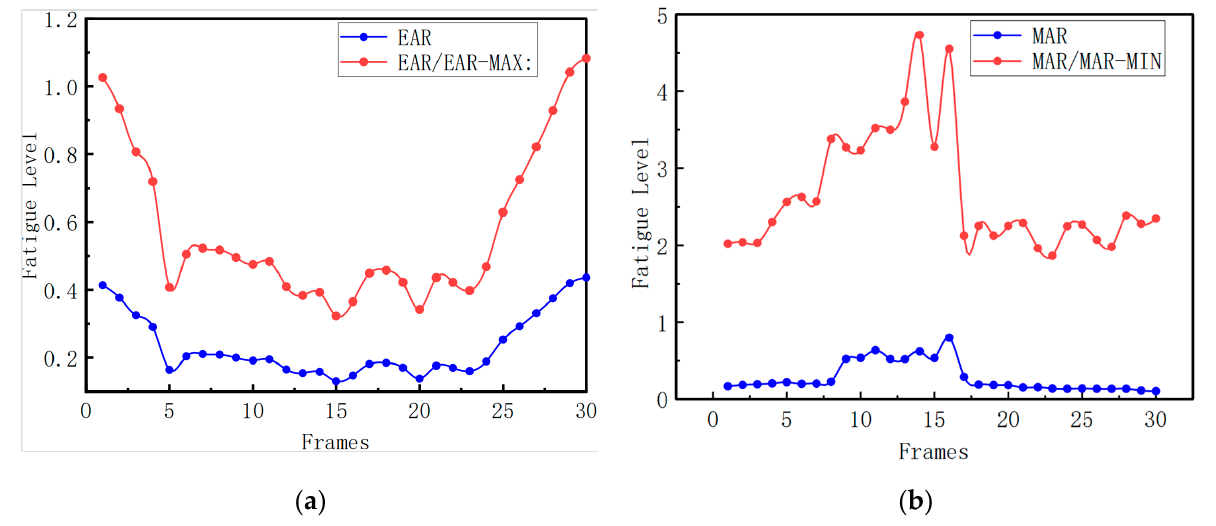
Figure 11. Comparison experiments between the conventional algorithm and the MAX-MIN algo- rithm: ( a ) shows the fatigue state detection comparison between EAR and EAR/EAR-MAX, and ( b ) shows the fatigue state detection comparison between MAR and MAR/MAR-MAX